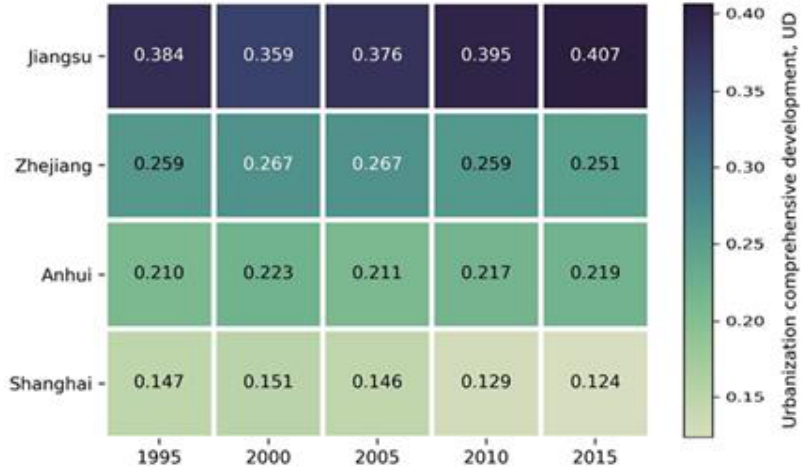
Figure 2. Overall urbanization development (UD) values of major cities in the YRD region.